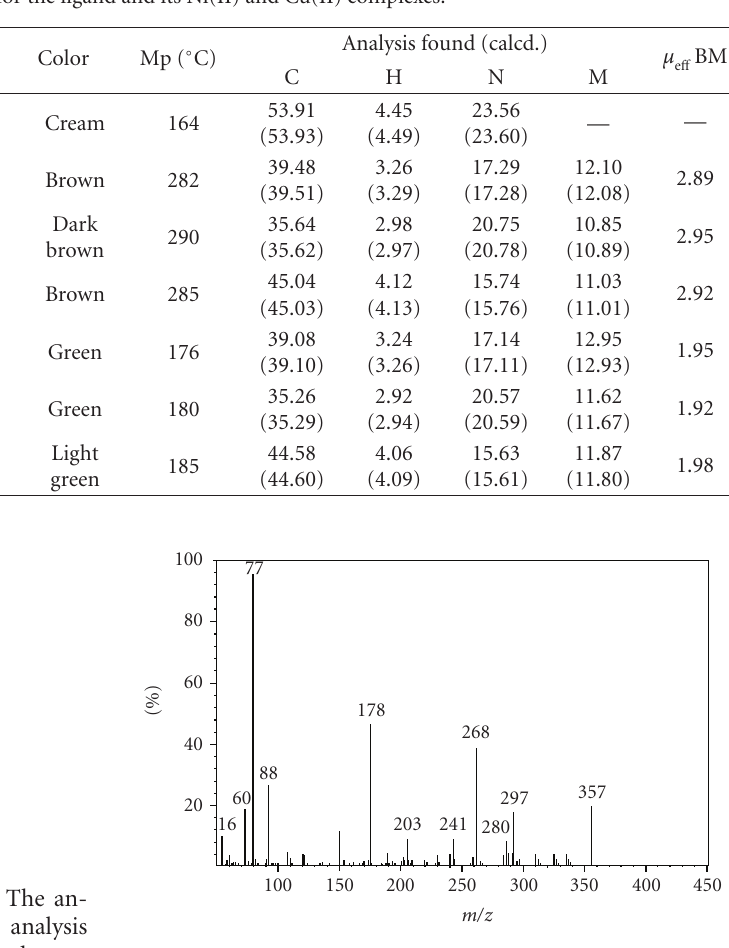
Figure 3: Electronic impact mass spectrum of ligand